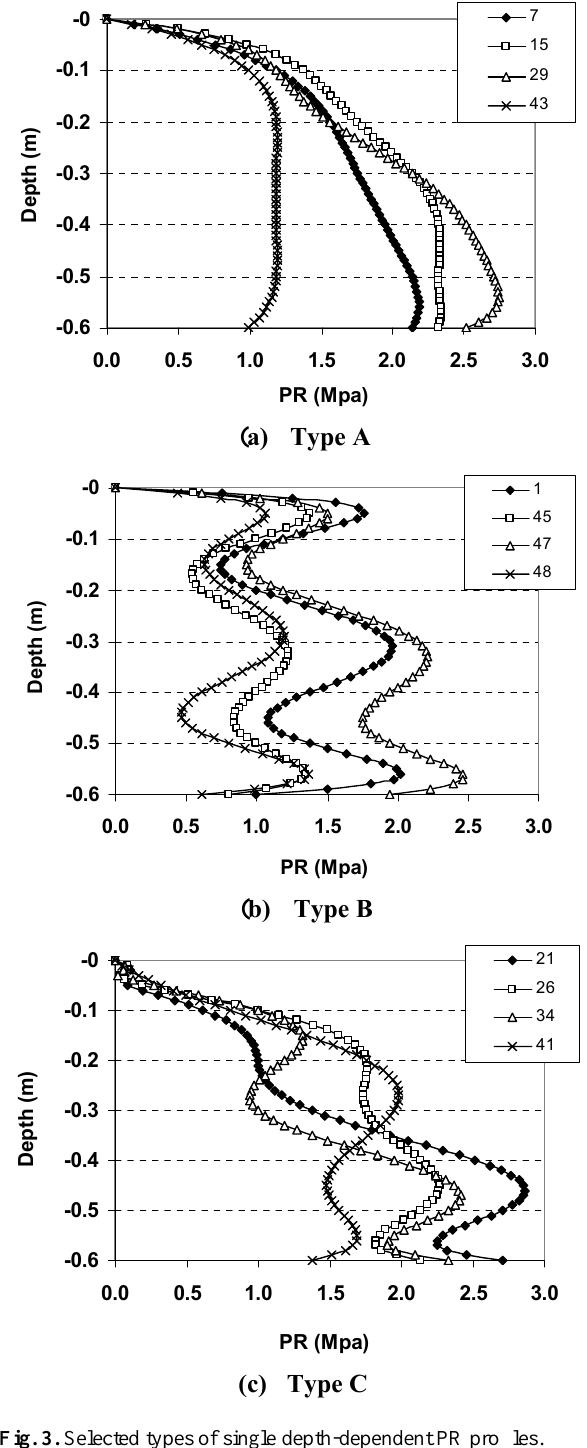
Fig. 3. Selected types of single depth-dependent PR profiles.